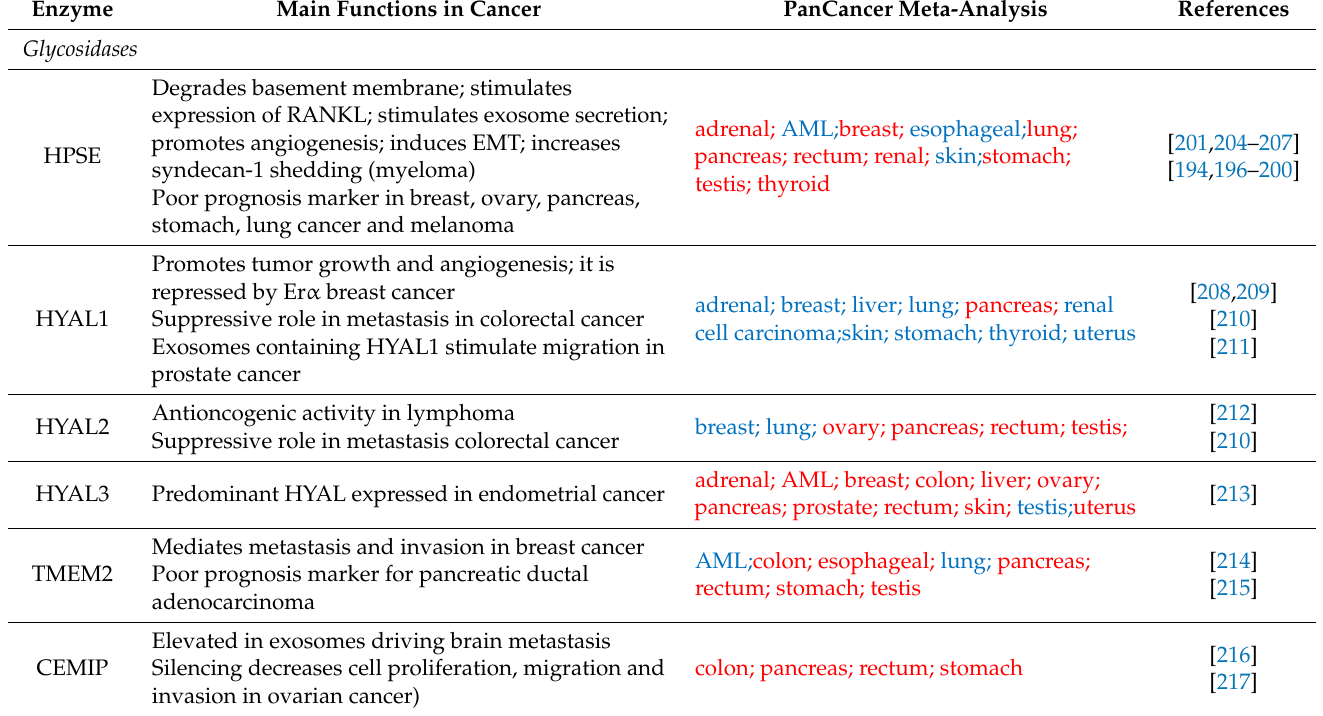
Table 3. The main functions of major glycolytic enzymes in cancer progression. Their prognostic value has been estimated by pan-cancer analysis in all available normal and tumor RNA Seq data from GEO, TCGA and GTex databases [59]. Significant differences of expression in tumor tissues compared to normal expression are marked with red (upregulation) and blue (downregulation) and have been computed by Mann–Whitney U